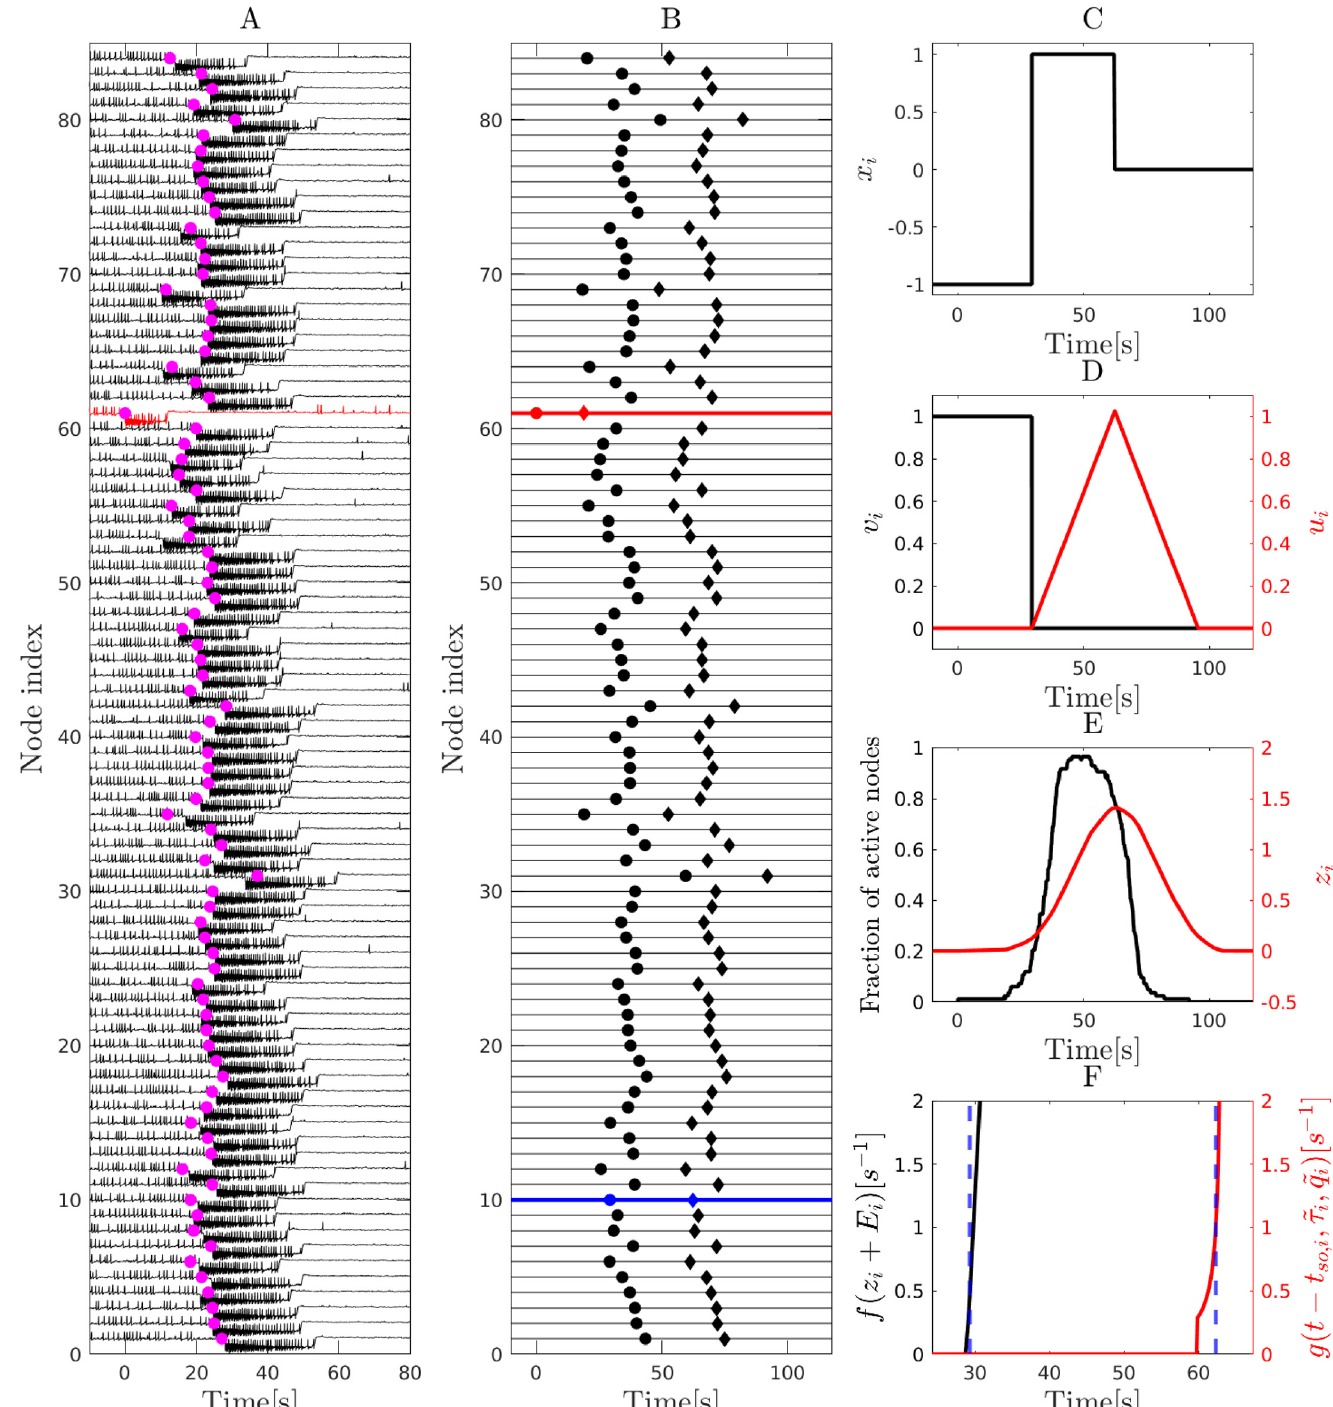
Fig 1. Dynamics of the probabilistic model. An example of seizure spreading dynamics in a patient-specific Epileptor network (subject P1) based on an 84-node parcellation of brain areas (Desikan-Killiany Atlas; see also Materials and methods) and the corresponding dynamics in the proposed probabilistic model. A Seizure spread observed in a simulation of a patient-specific Epileptor network model with global coupling strength set to w = 0.45, and excitability levels set to x 0 = − 2.173 and x 0, ez = − 1.8 for the surrounding and epileptogenic nodes, respectively (Materials and methods). The seizure starts at the EZ node (red; node 61; onset time at 0), and then spreads to all other nodes. A postical refractory period follows after seizure termination in each node. (The “spikes” preceding the seizure onset correspond to interictal spikes). Pink dots show rescaled seizure onset times obtained by simulating the proposed probabilistic model shown in panel B. B Seizure spread in a